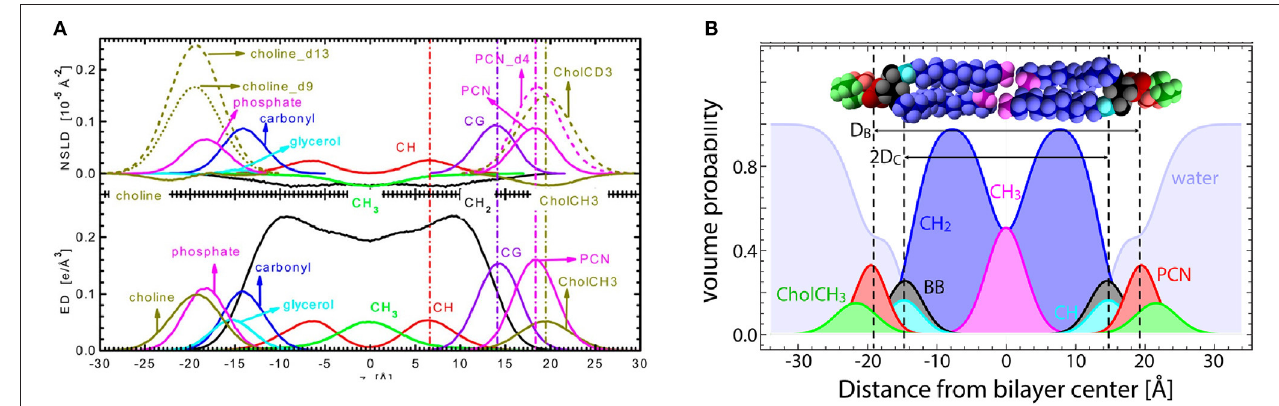
FIGURE 7 | The SDP model. (A) Neutron SLD (NSLD) and electron density (ED) profiles obtained from MD simulations as a function of distance (z) along the bilayer normal of a PC bilayer. The left-hand side of the panel shows the individual components of a PC lipid molecule, whereas the right-hand side shows the appropriately parsed component groups. Dashed vertical lines indicate the peak location in the NSLD (upper) and ED (lower) profiles. For the parsing scheme used in the SDP model, component grouping peak profiles align for both NSLD and ED profiles, even when certain component groups are deuterated, as is often done in neutron scattering. (B) Volume probability distributions for the parsed component groups as a function of z along the bilayer normal used in the structural determination of sphingomyelin bilayers. Volume probability distributions are used to model raw scattering form factors by calculating ED or NSLD profiles and then Fourier transforming them to fit the raw scattering data. Figure was adapted from Ku ˇ cerka et al. (2008) and Doktorova et al.